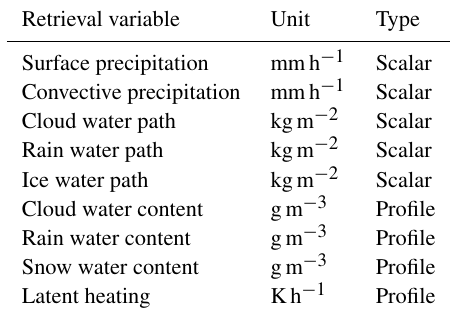
Table 1. Retrieval quantities in the retrieval database. Table 2. Channels of the GMI and MHS sensors used for the re- trievals in this study.